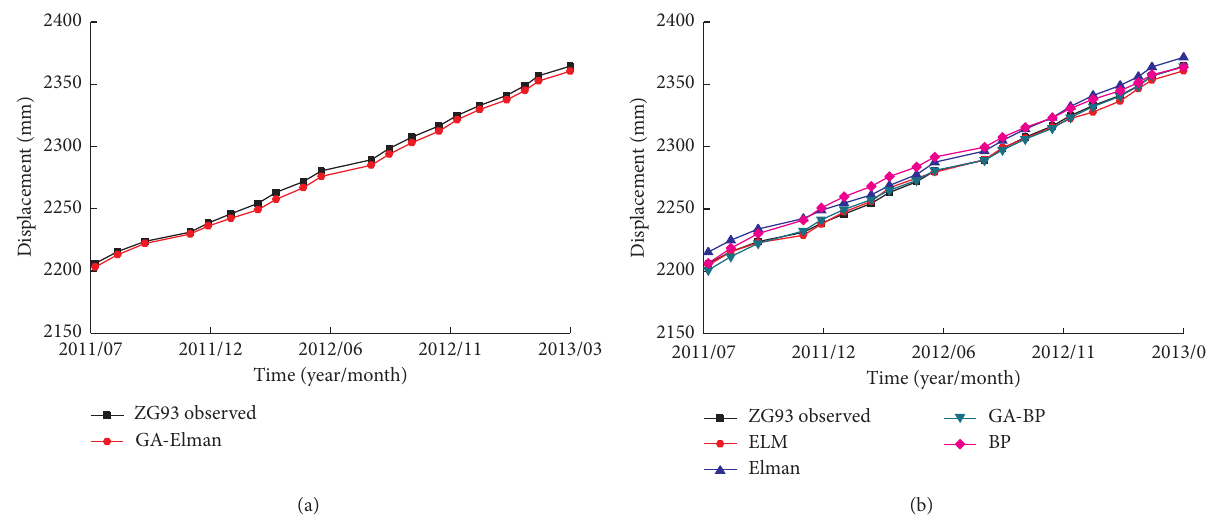
Figure 8: Prediction performance of different models: (a) GA-Elman model; (b) other models. Table 1: Comparisons of the evaluation indicators on point ZG93 of the trend component displacement prediction models. Models